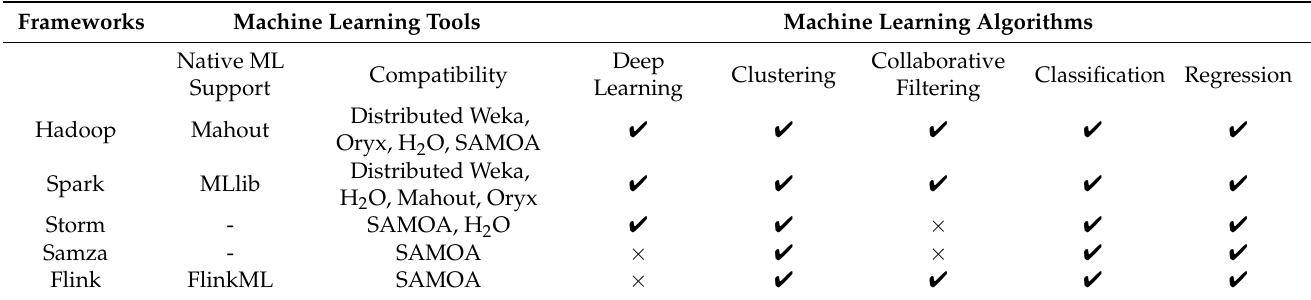
Table 8. Support for machine learning tools and algorithms in big data frameworks.